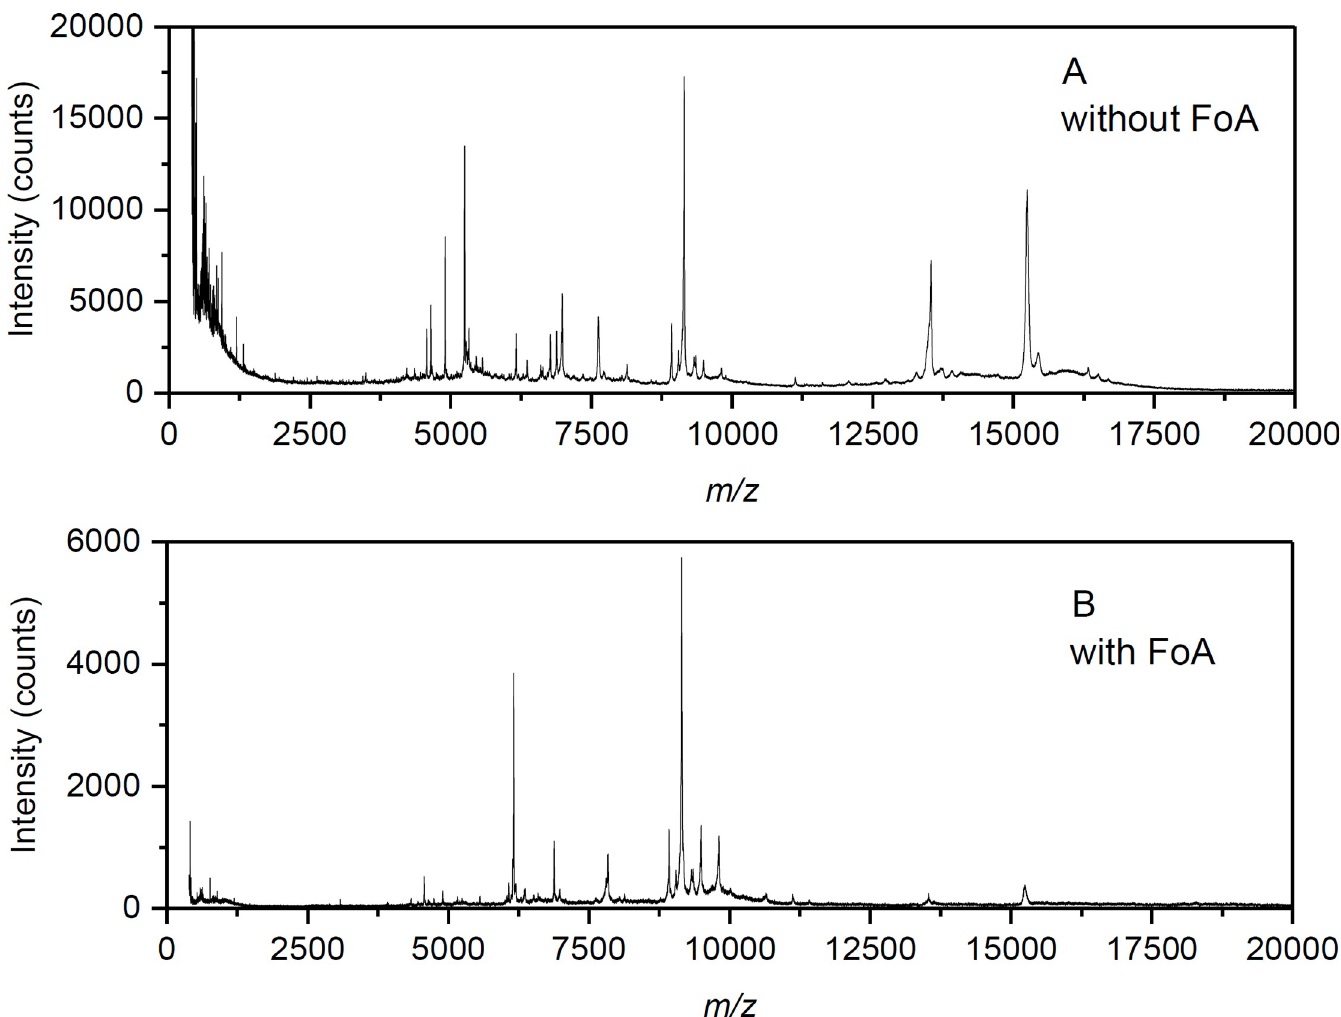
Fig 2. Intact cell MALDI-MS of cyanobacteria: evaluation of FoA application. The measurements were carried out on Microflex LRF20 MALDI-TOF instrument. Panel A shows a mass spectrum acquired after employing the dried-droplet sample preparation technique with the optimized binary matrix (FA:SA, 5:15 mg � ml -1 in ACN/2% v/v TFA, 7:3, v/v). Panel B shows a different result when cyanobacterial cells ( Chroococcidiopsis spp., UPOC 169/2016) were first spotted on the target plate, overlaid with 25% (v/v) FoA, air-dried, and finally overlaid with the above matrix solution prior to spectrum